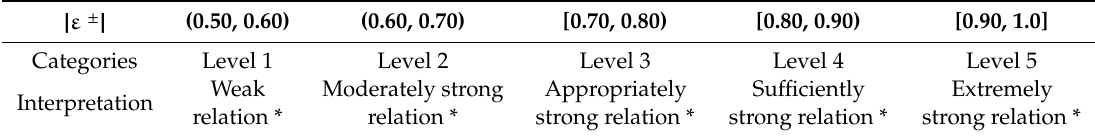
Table 1. The Javed’s grey incidence (JGI) scale [31].